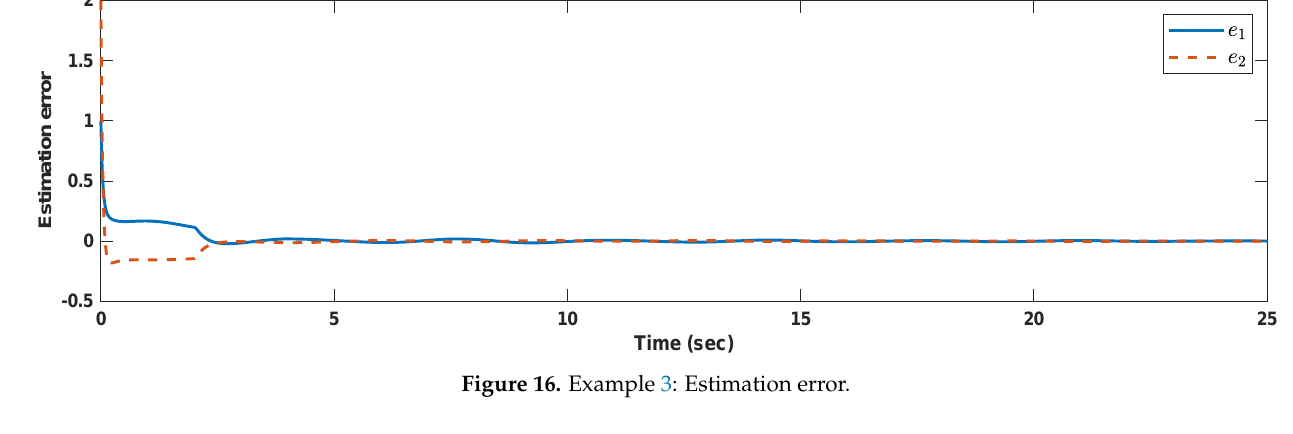
Figure 16. Example 3: Estimation error.